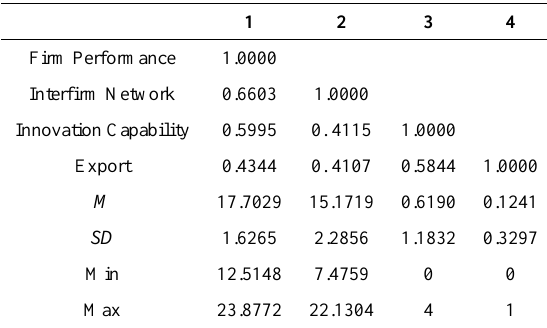
Table 1. Descriptive Statistics and Correlations